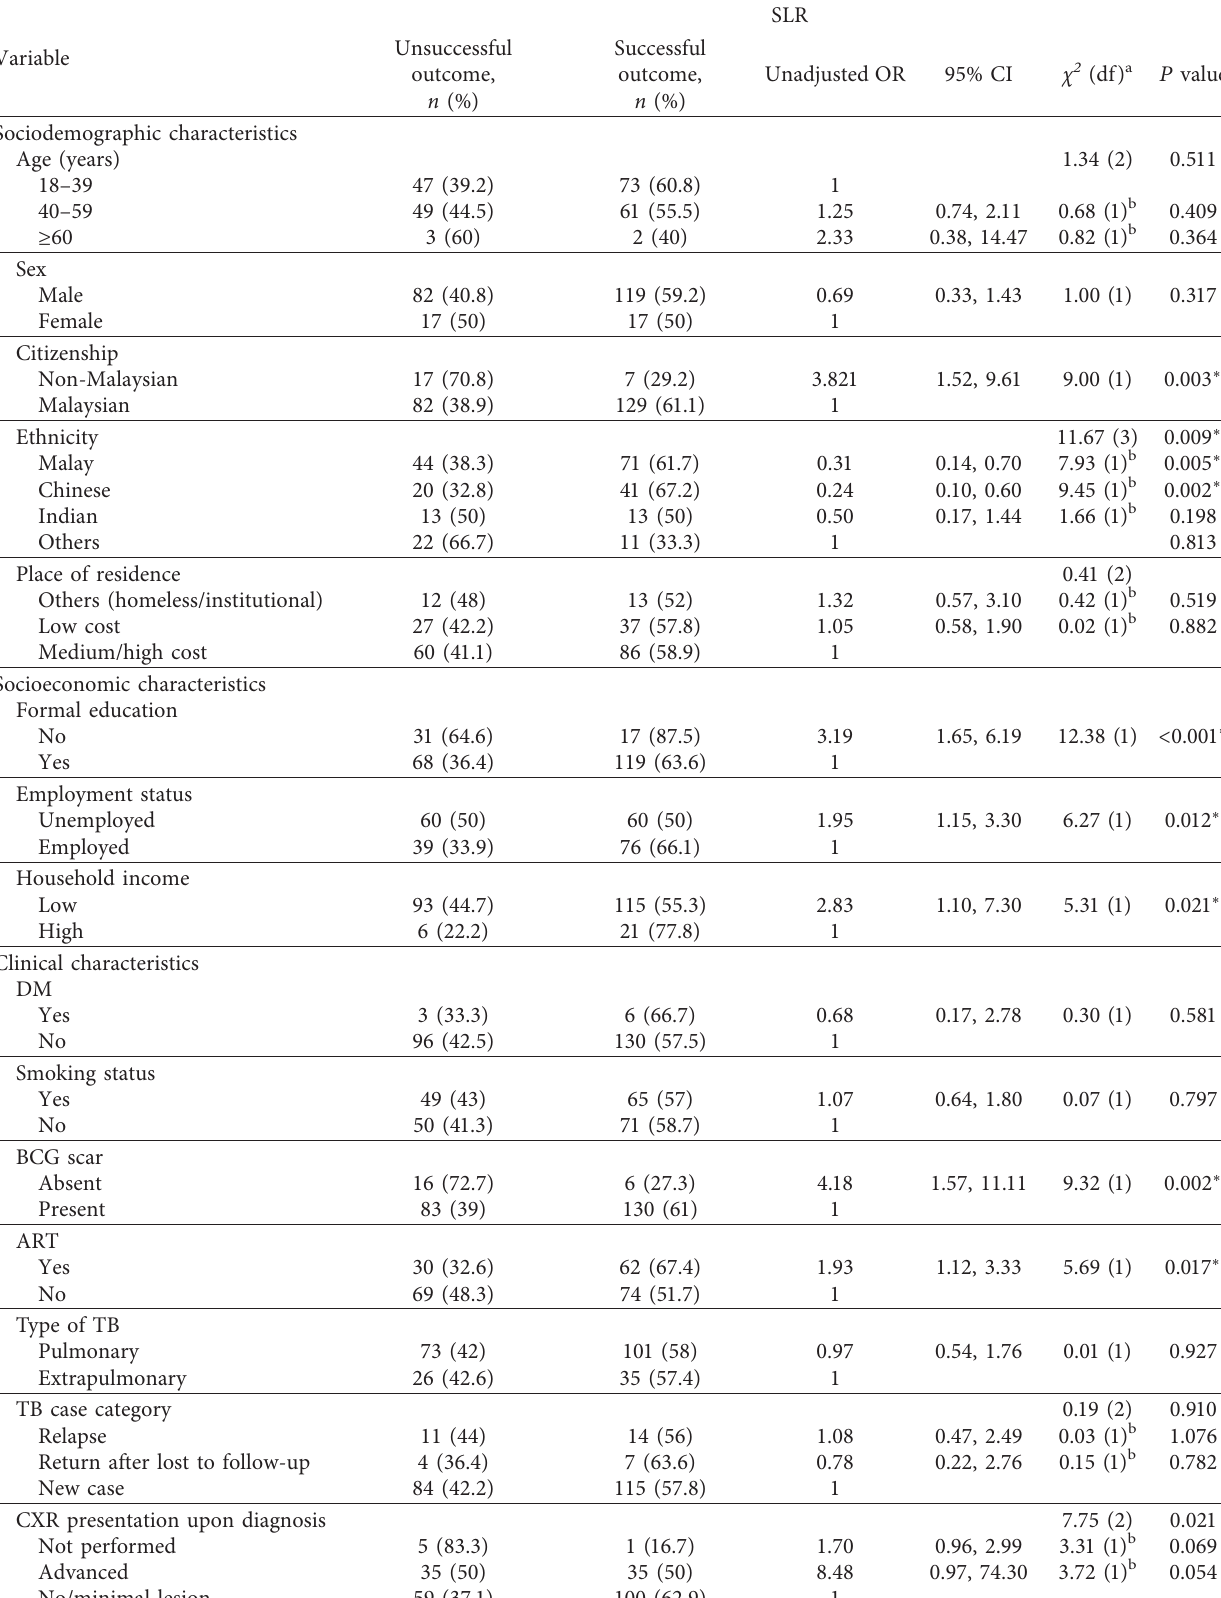
Table 3: Simple logistic regression (SLR) identification of factors associated with unsuccessful TB treatment outcome in patients with TB- HIV in Kuala